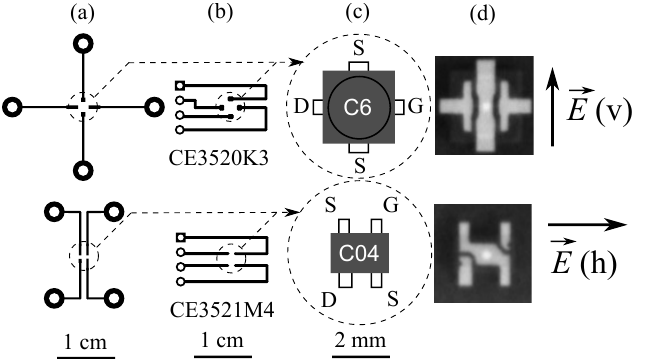
Figure 2. Layouts of printed circuit boards ( a , b ), sketches ( c ), and X-ray images ( d ) of the investigated HEMTs where brighter dots indicate the HEMTs’ location areas. Right panel: Vertical (v) and horizontal (h) polarizations of the electric field of an incident THz wave with respect to the relevant PCB